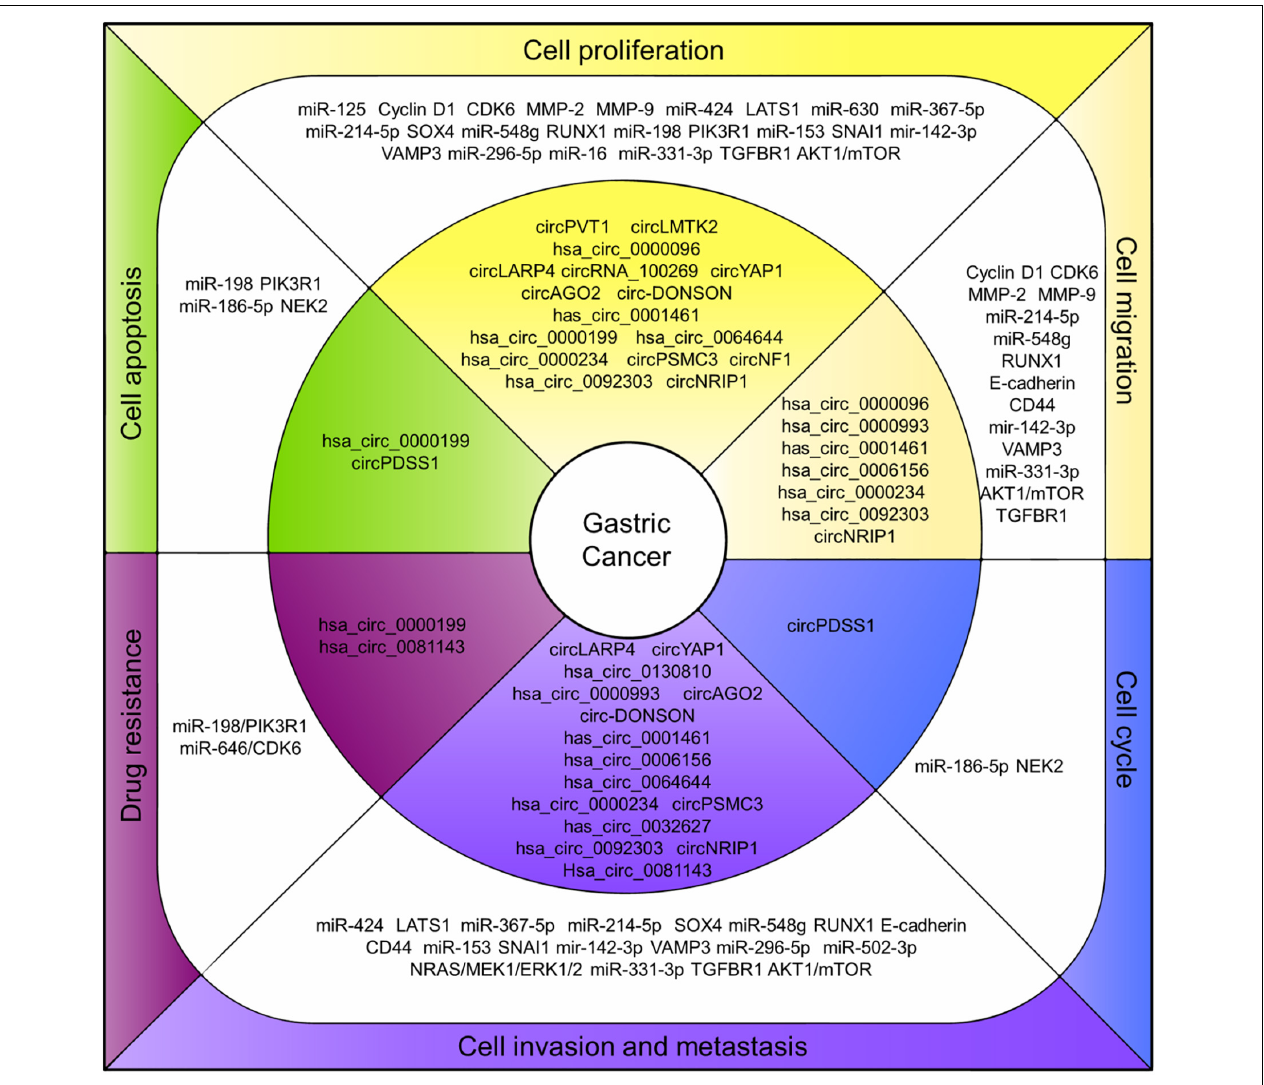
FIGURE 2 | CircRNAs associated with human GC. CircRNAs associated with human GC. Deregulation of circRNAs (inner layer) regulates endogenous miRNAs and related proteins/pathways (middle layer) that ultimately lead to associated cell processes in GC (outer layer)